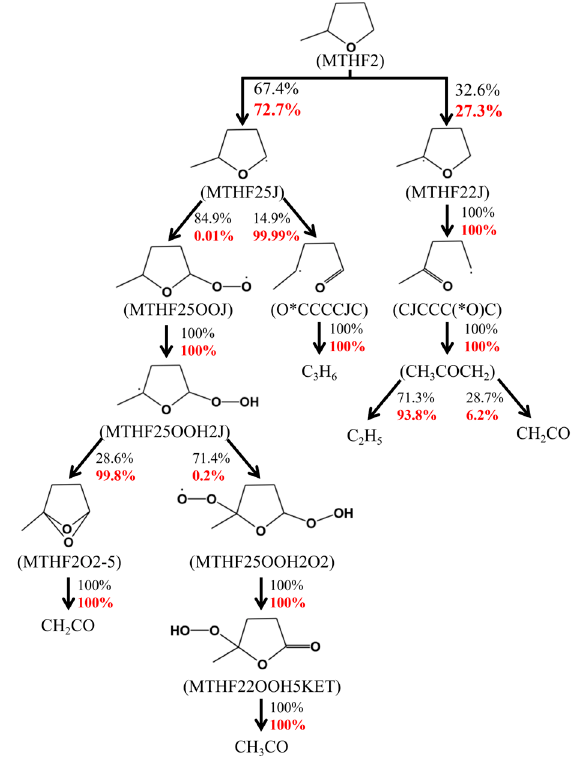
Figure 2. Schematic of RPA for stoichiometric MTHF2/air at 20% fuel consumption at a pressure of 40 bar, temperatures of 700 K (black numbers) and 1500 K (red numbers).